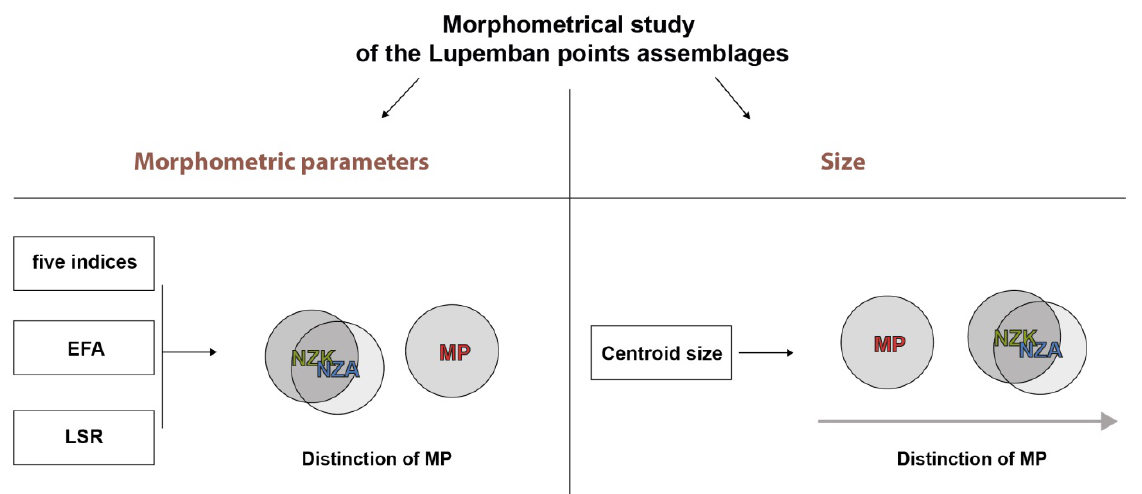
Figure 21. Summary of the results obtained with the different approaches for the Lupemban